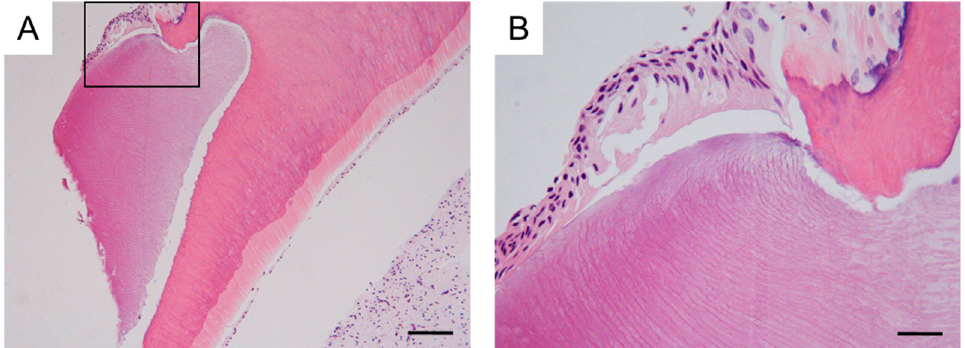
Figure 4. Histopathological evaluation of the third supernumerary tooth. ( A ) Representative histopathological examination images following hematoxylin and eosin staining of a tissue section of the third supernumerary tooth, including enamel, dentin, and pulp formation. Scale bar = 100 μ m (×40). ( B ) High-magnification image of the box shown in ( A ). Enamel covered by reduced enamel epithelium and dentin is seen. Scale bar = 20 μ m (×400).